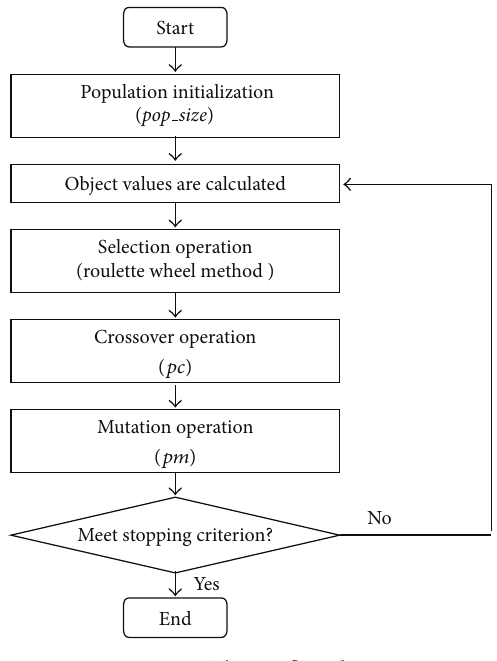
Figure 4: The GA flow